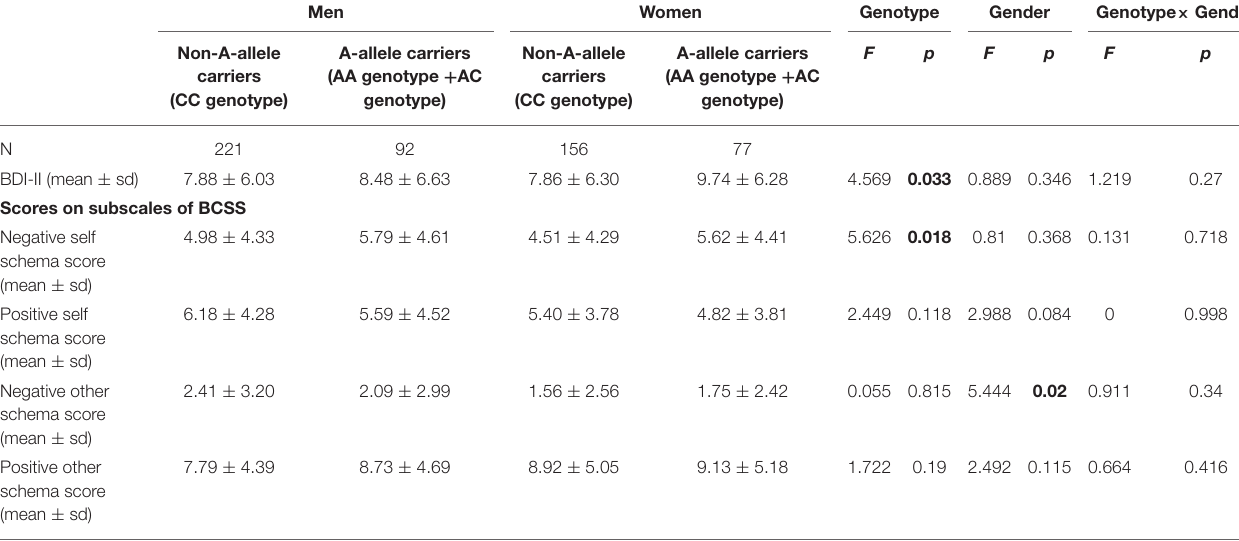
TABLE 4 | The results of two-way ANCOVA controlling for age, with genotype and gender as independent